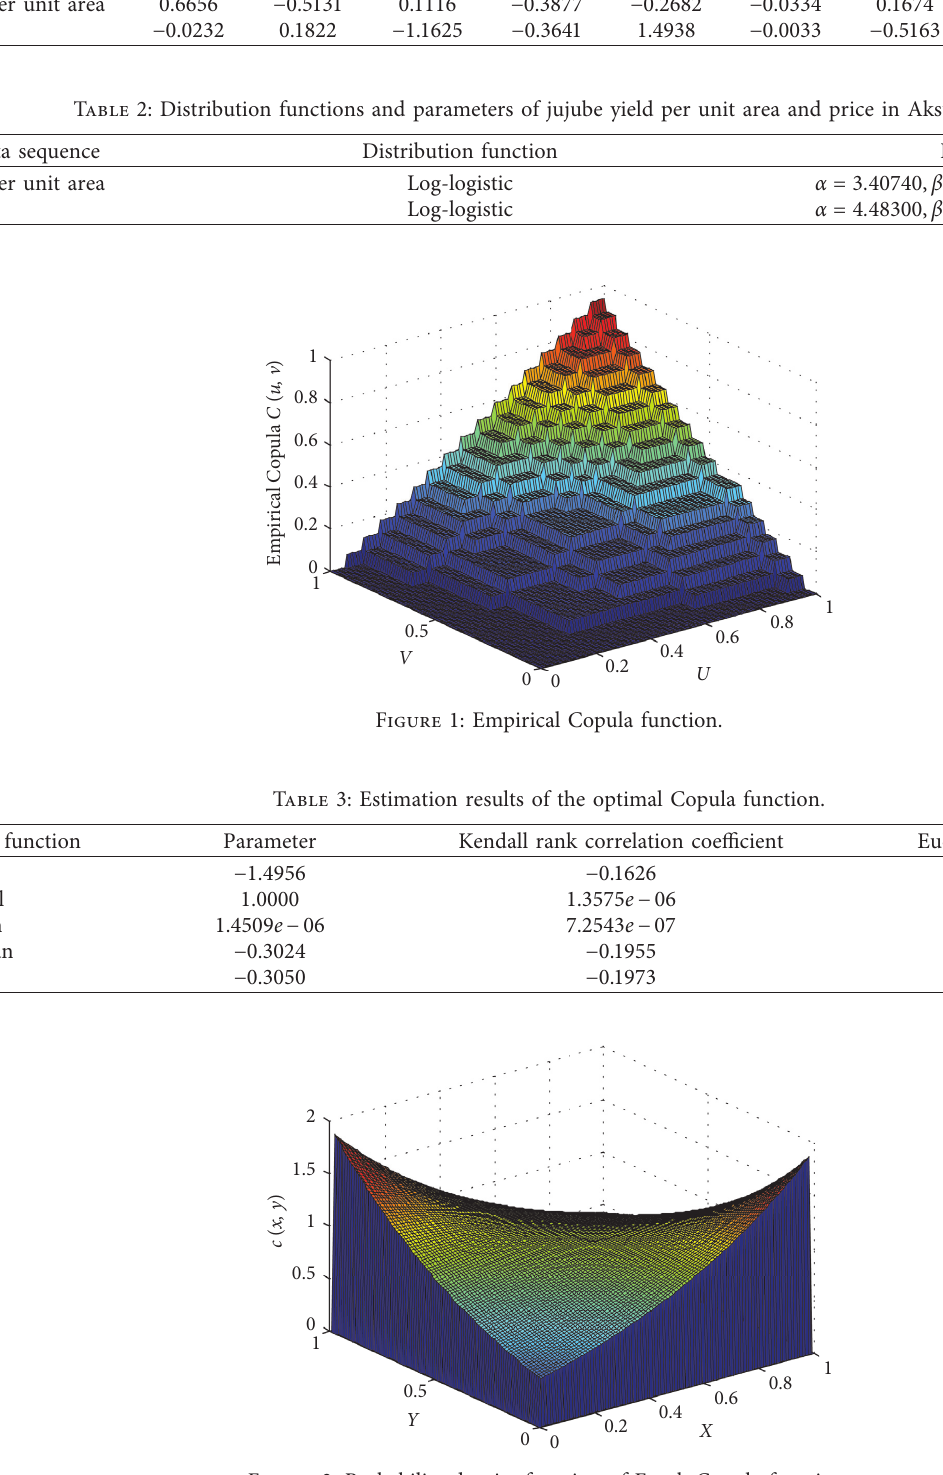
Figure 2: Probability density function of Frank Copula